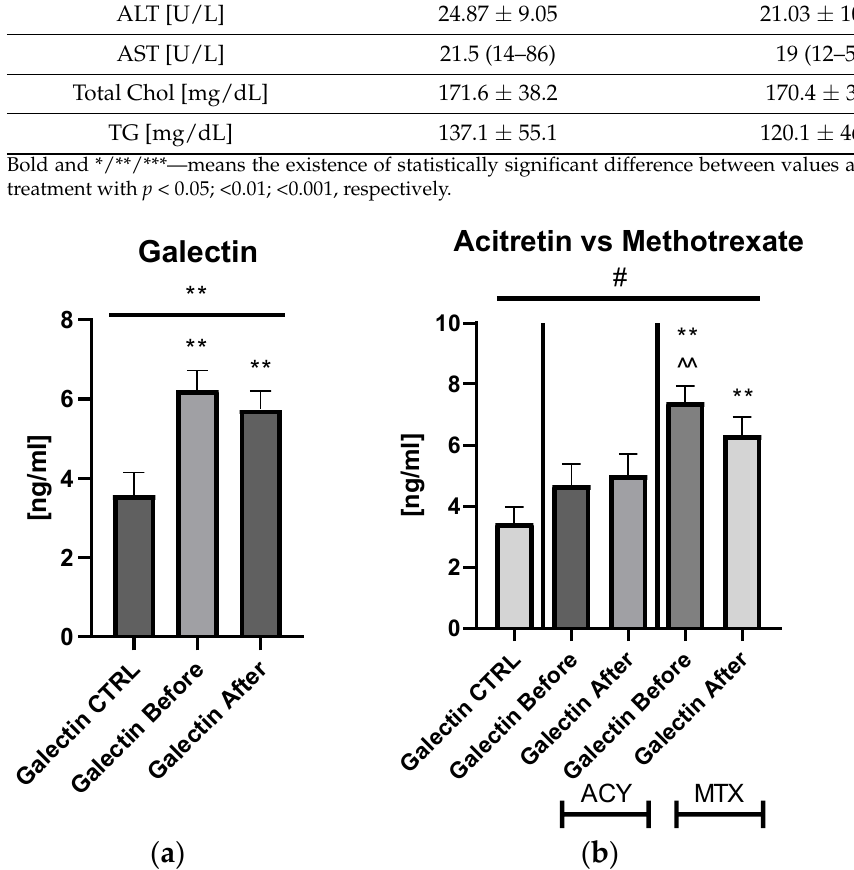
Bold and */**/***—means the existence of statistically significant difference between values after and